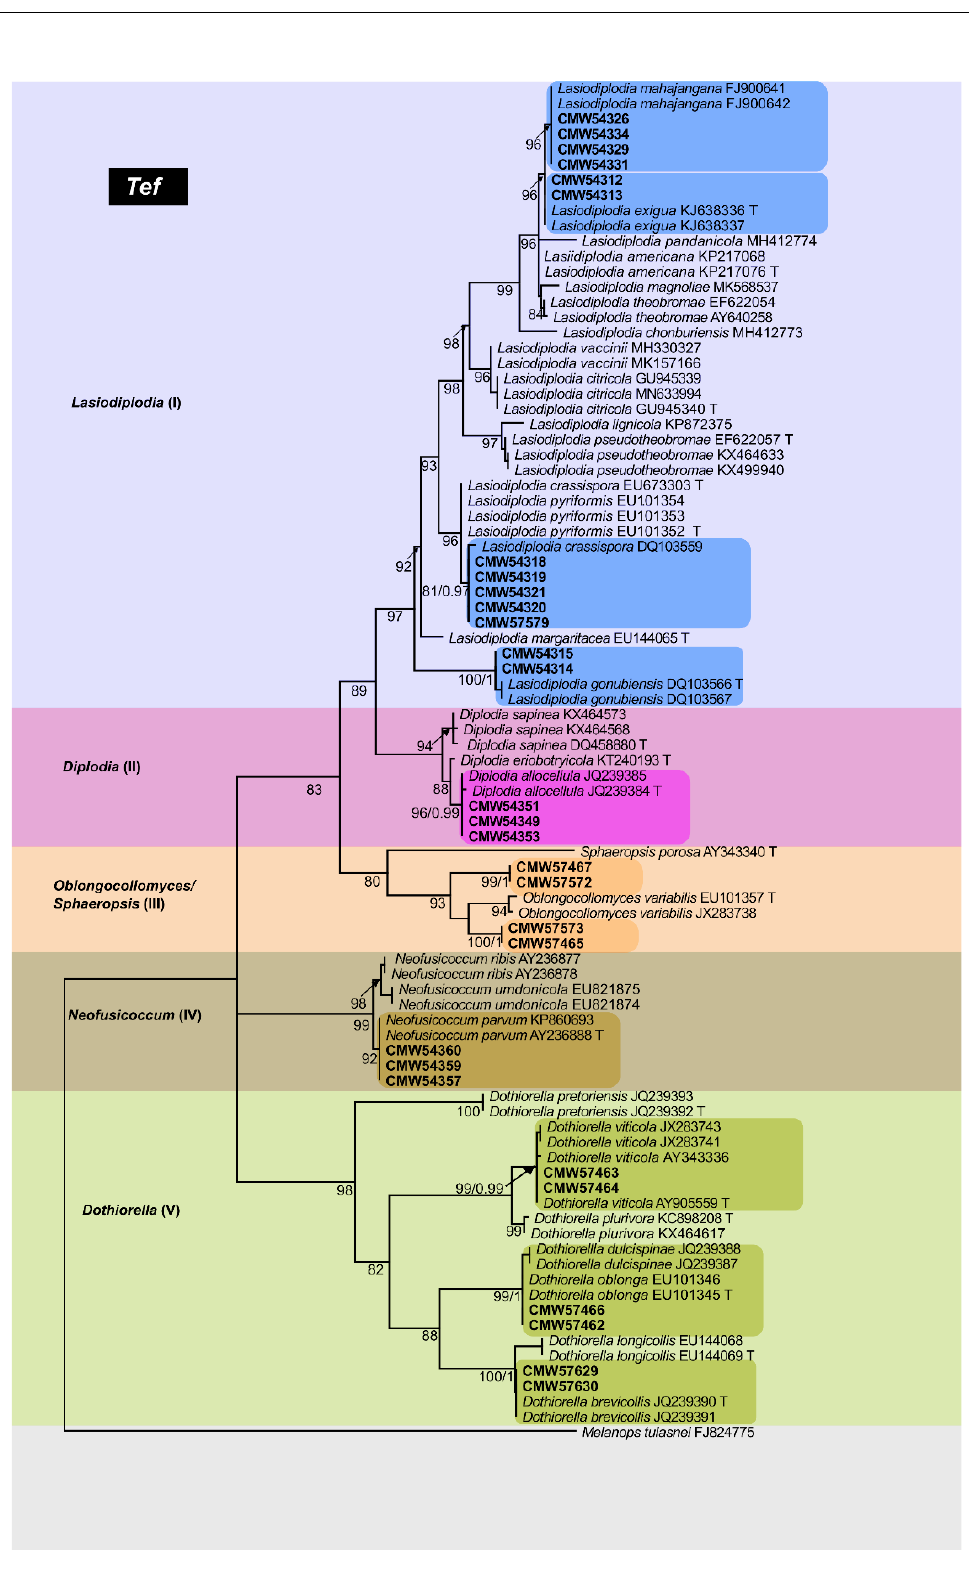
Figure 3. Maximum likelihood phylogenetic tree obtained from analyses of the tef- 1α data including species of Botryosphaeriaceae . Bootstrap values >70% and posterior probabilities values >0.95 are shown at the nodes. Isolates in bold were obtained during this study. The tree was rooted to isolates of Melanops tulasnei.